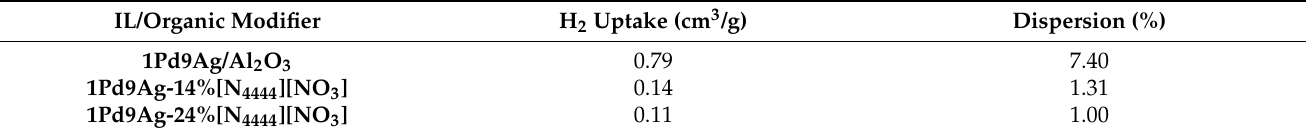
Table 1. Physicochemical properties of the fresh uncoated and SCILLs up to 2 ML. IL/Organic